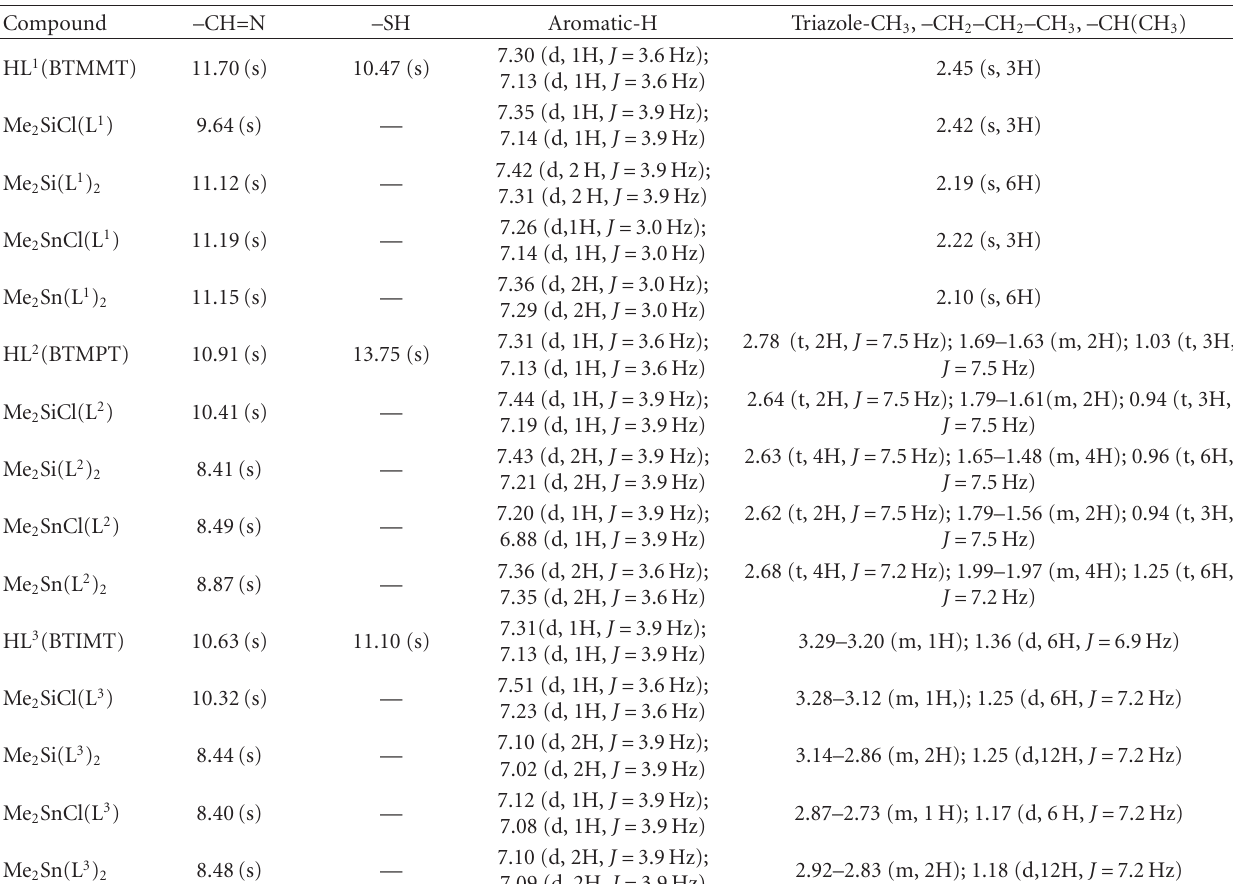
Table 3: 1 HNMR chemical shifts of the ligands and their metal